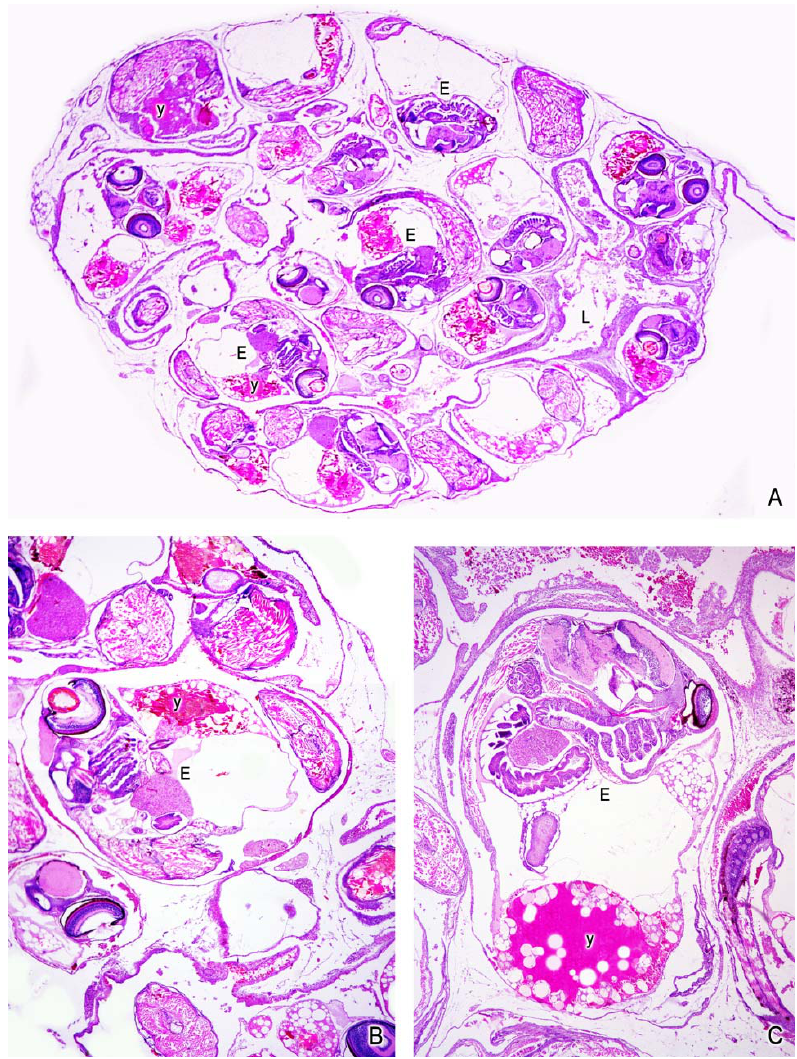
Figure 7. Ovaries during late intrafollicular embryogenesis. ( A ) Ovary of Poecilia reticulata with embryos (E) during late gestation. The development of embryos is more advanced compared with that seen in the embryos of the Figures 4 and 5; consequently, the reduction of yolk is also seen. 12×. ( B,C ) Details of embryos (E) in late stage of development and reduction of yolk. 78×.